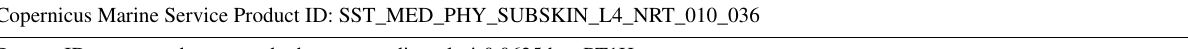
Table 2. The Copernicus Marine Service MED DOISST product description